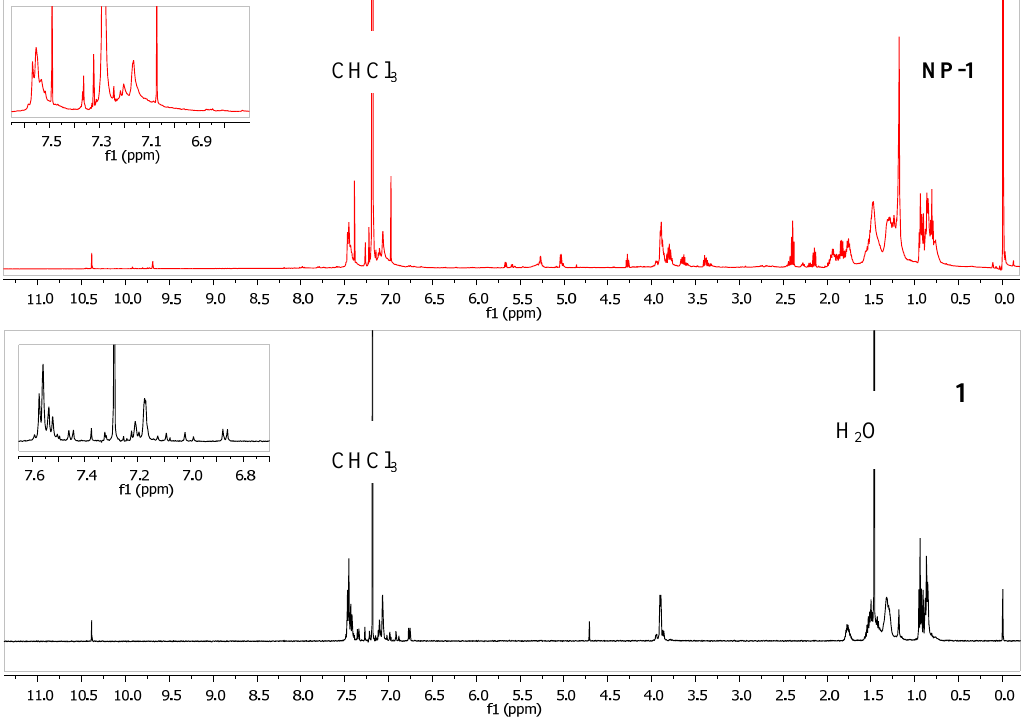
Figure 1. 1 H-NMR spectra of compound 1 and NP-1 measured in CDCl